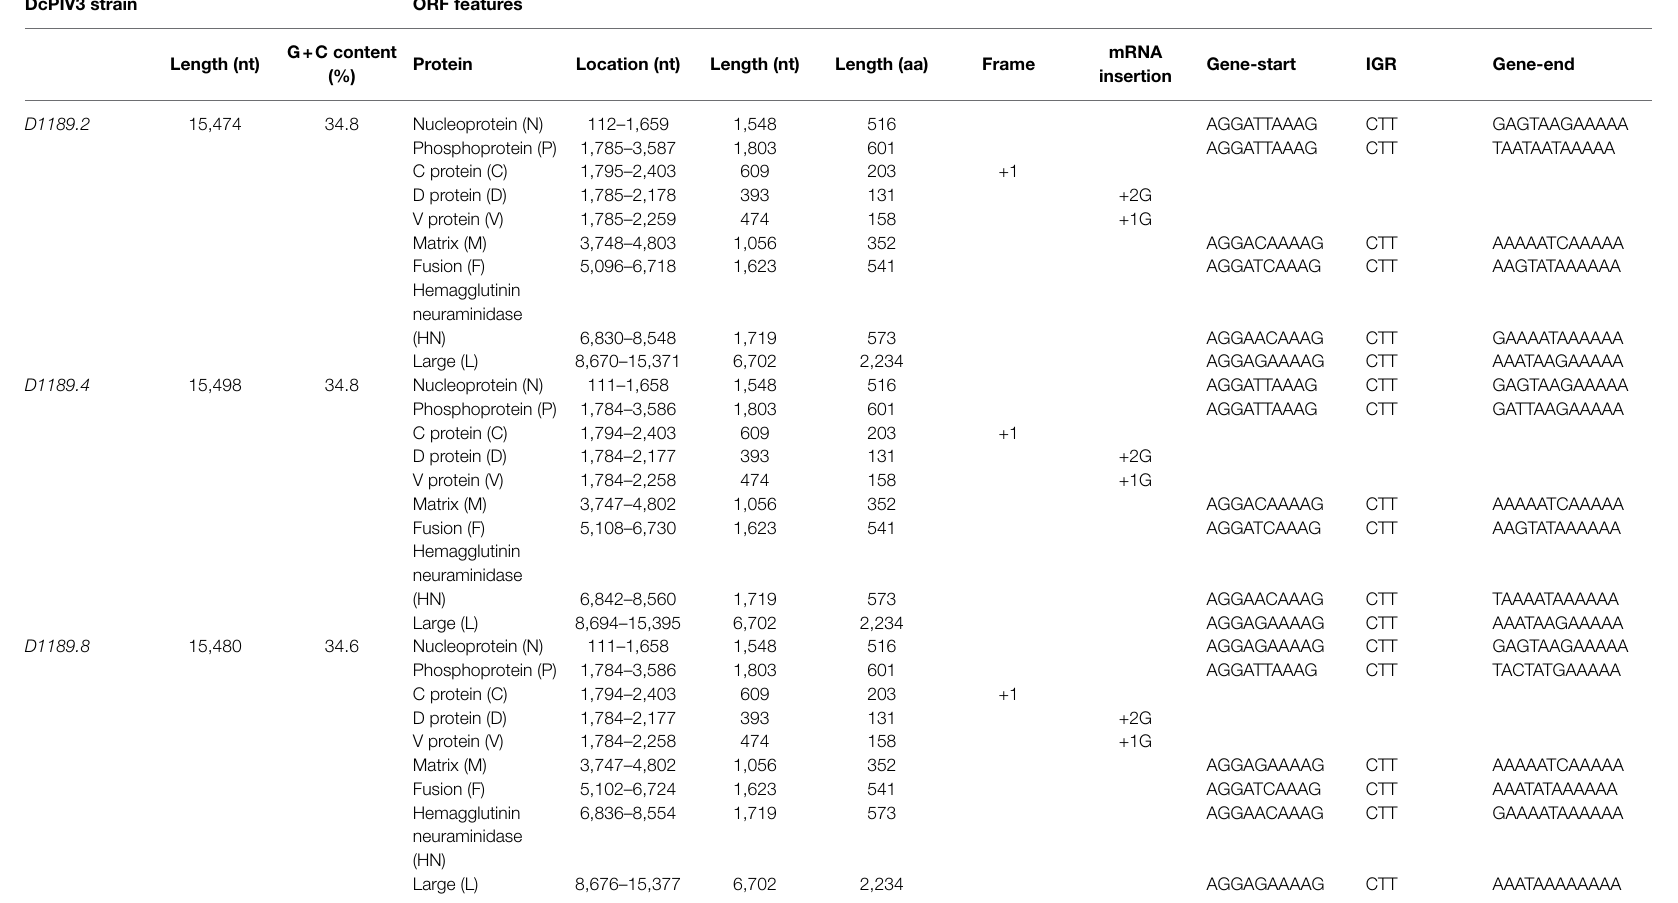
TABLE 2 | Genomic features and coding potential of the three DcPIV3 strains isolated from dromedary nasal samples. DcPIV3